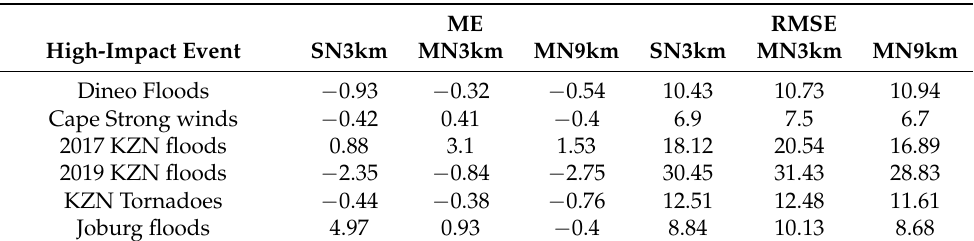
Table 4. The ME in column 2 to 4 and RMSE in columns 5 to 7 for different CCAM configurations and for the six events.